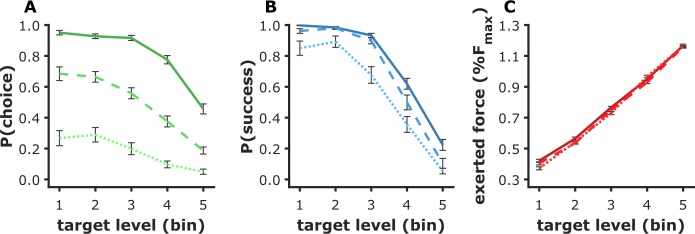
Action-related variables in the effort task.The three action-related dependent variables—choice (acceptance) rate (A), success rate (B), and exerted force (C) are shown as a function of target force level (imposed by the task). Only accepted trials were included in the analysis of success, and only successful trials in the analysis of force. Graphs show mean ± inter-subject SEM per force level. Darker colors and more continuous lines indicate bins (tertiles) of items with higher desirability ratings. Ratings were z-scored for every subject before binning.